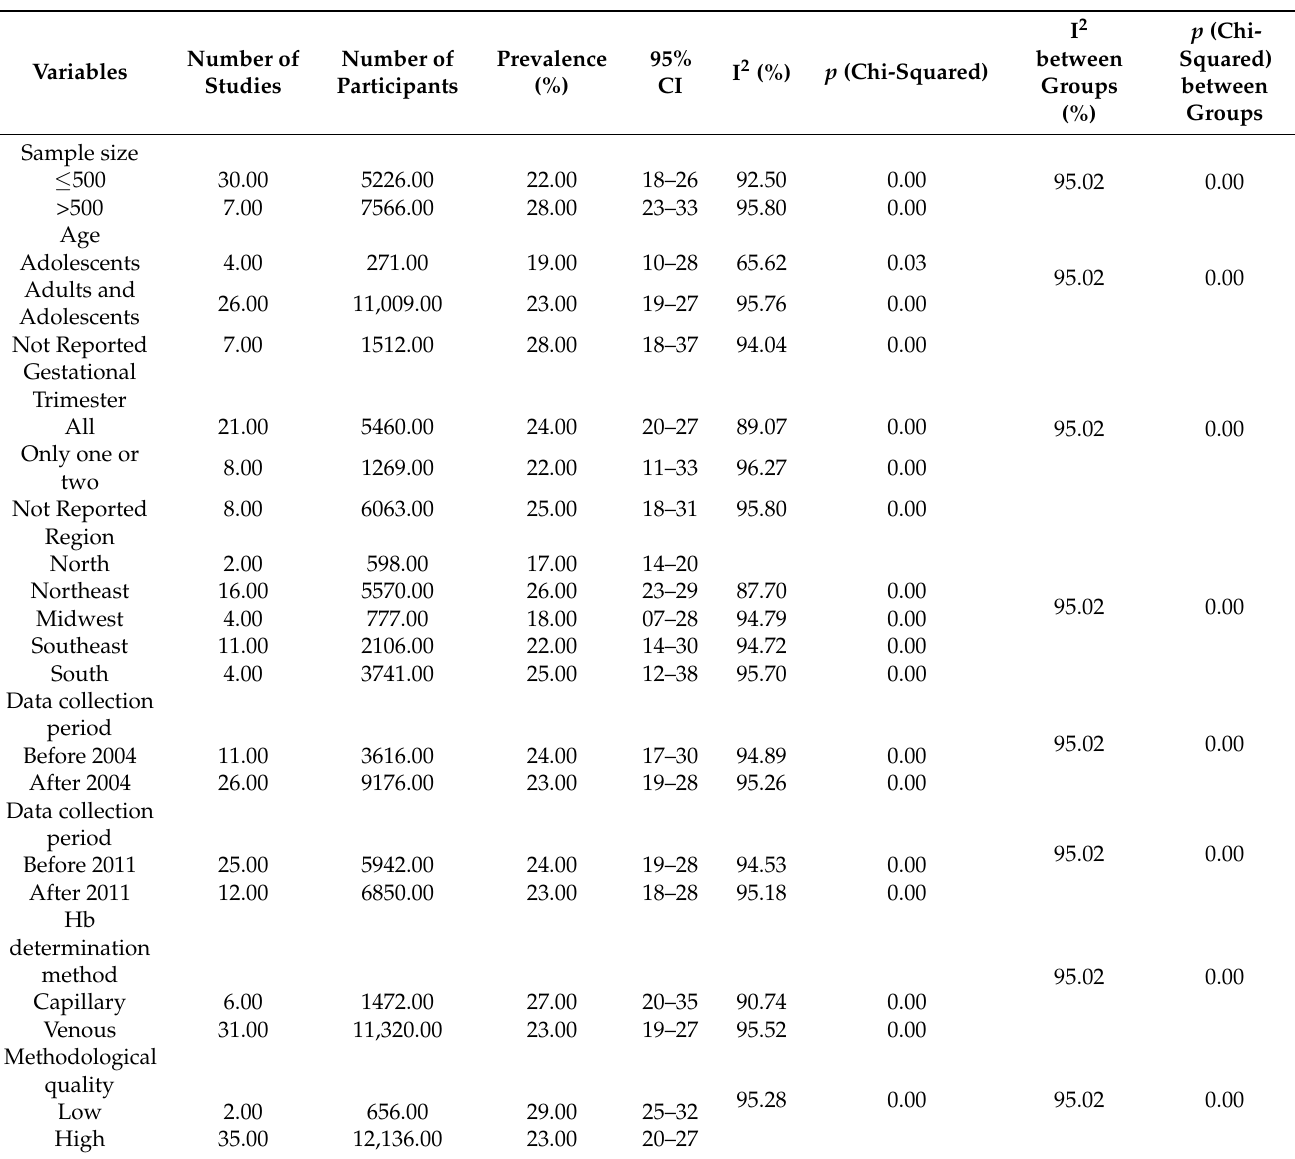
Table 2. Prevalence of anaemia in Brazilian pregnant women and heterogeneity in subgroup analysis and between